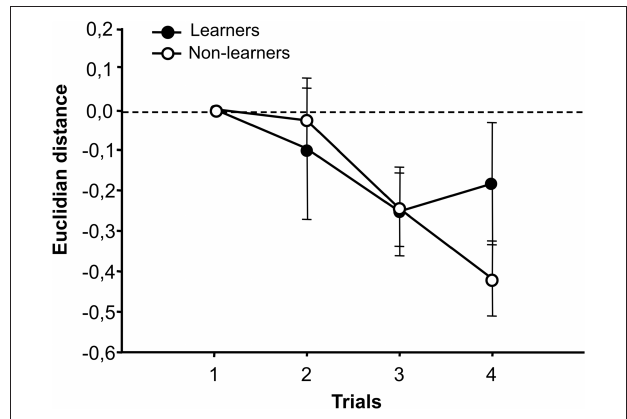
Figure 4 | Similarity between activity patterns of CS + and CS − . The Euclidian distance between CS + and CS − activity patterns was calculated both for learners and non-learners in the putative neural space with 21 dimensions defined by the 21 glomeruli under study. This distance is a measure of perceptual similarity between odors (larger distance: less similarity, shorter distance: more similarity). The original distance between odors before conditioning (i.e., in the first trial) was normalized to 0 to facilitate comparisons between learners and non-learners. We found no changes in perceptual similarity between CS + and CS − activity patterns in the course of training between groups (group effect: p = NS) but whereas the similarity between CS + and CS − did not change along trials for learners (trial effect, p = NS), the similarity decreases for non-learners (trial effect, *** p <